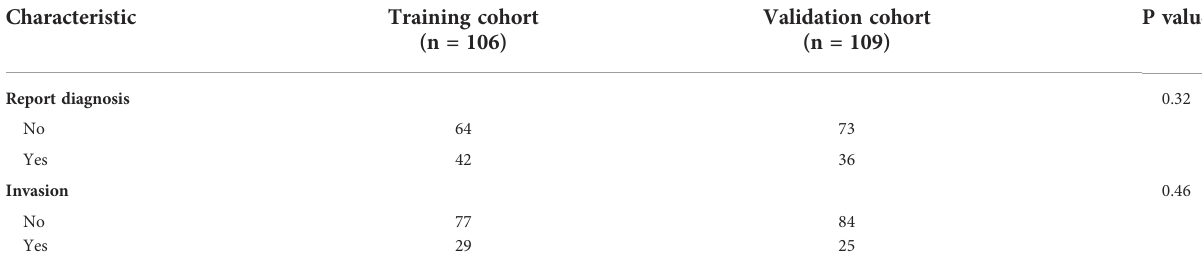
Table 3. The extent of encasement predicted CA involvement.